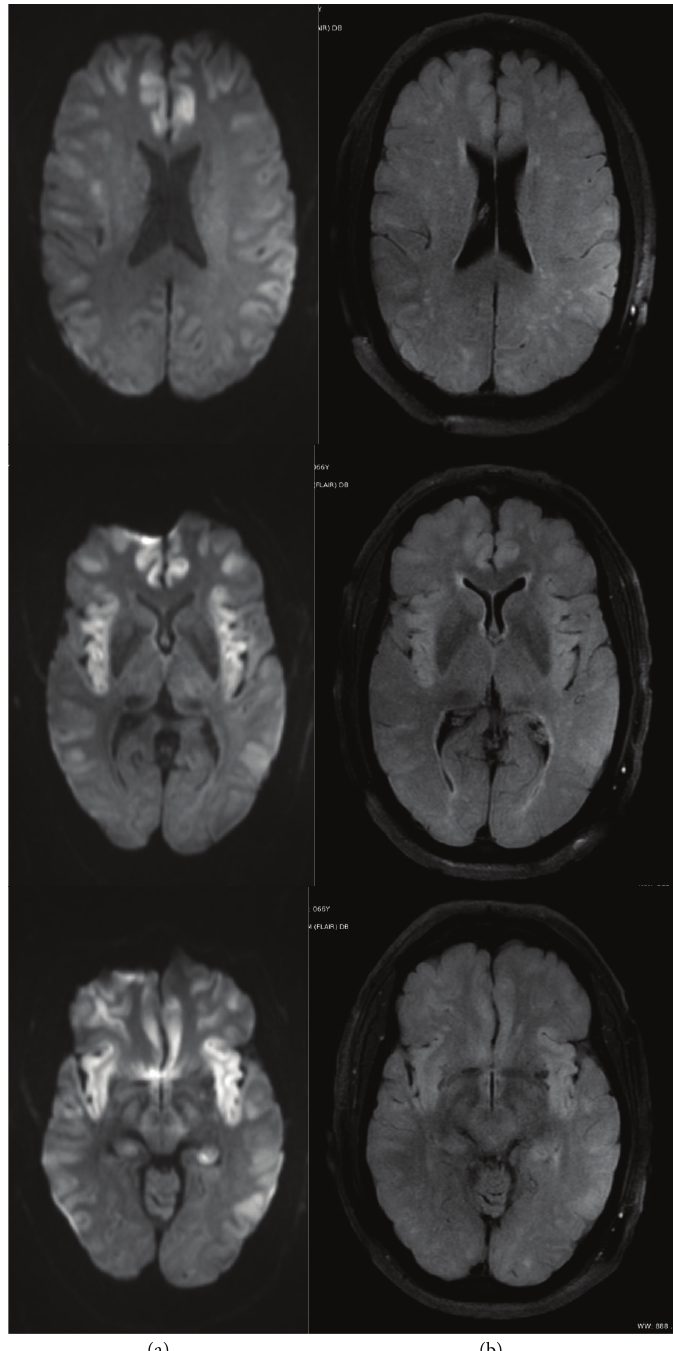
Figure1:MRIofthebrain((a)DWIsequence,(b)FLAIRsequence)onday3afterpresentation,showingextensiveareasofrestricteddiffusion with associated FLAIR hyperintensity involving bilateral temporal lobes, bilateral insular, bilateral frontal, and parietal regions in cortical and subcortical areas and diffuse mild effacement of the cerebral